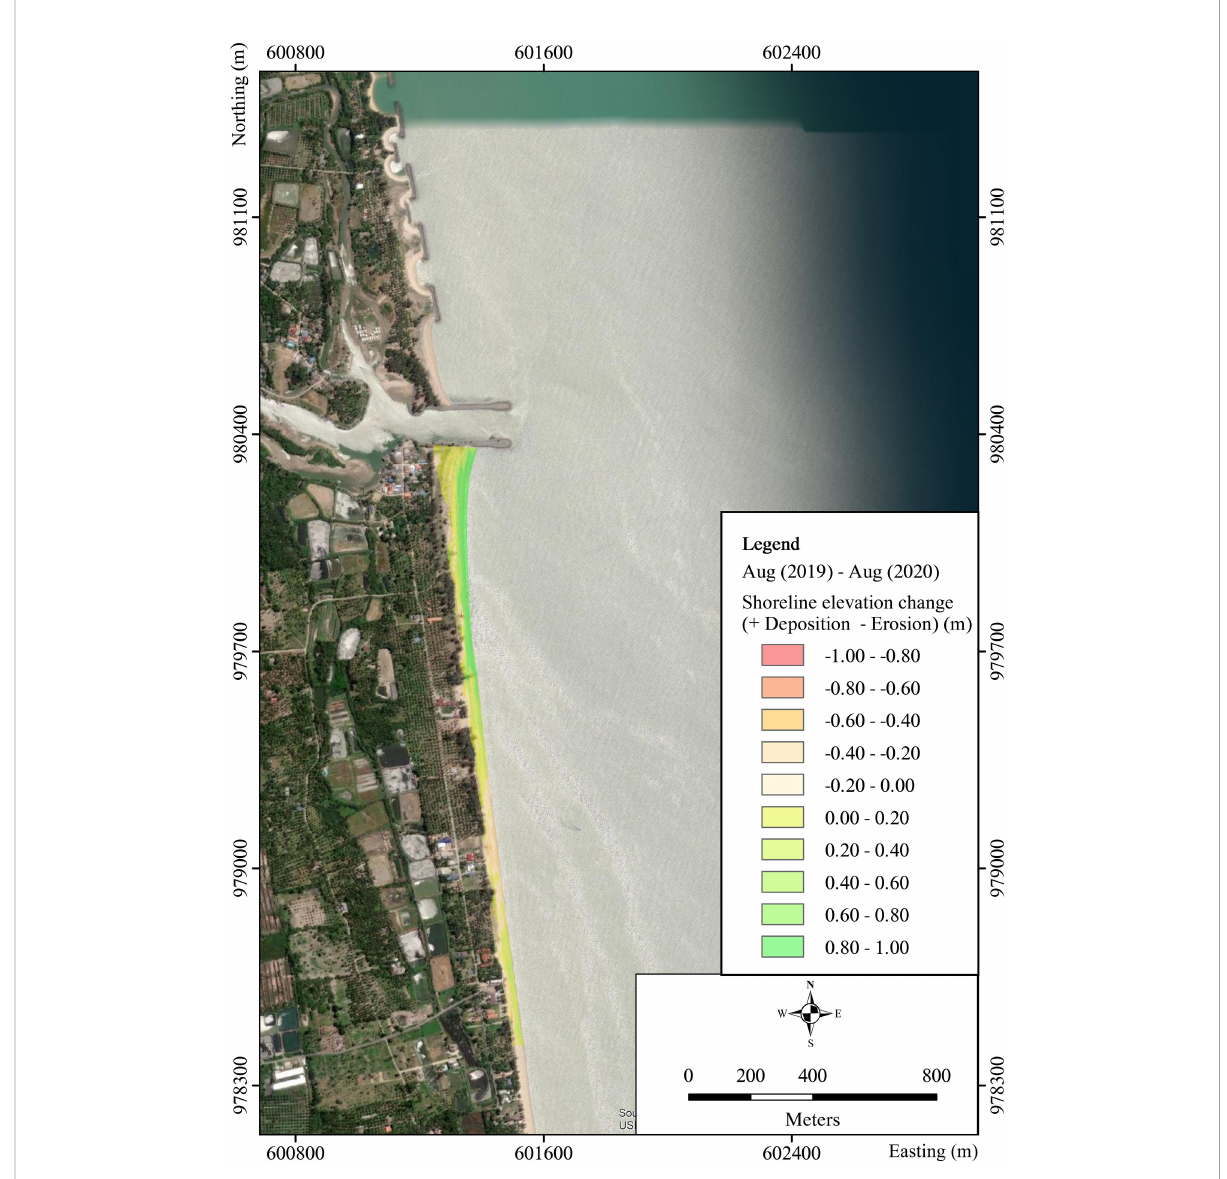
FIGURE 6 Differences in coastal elevation at the updrift Krai jetty (August 2019 versus August